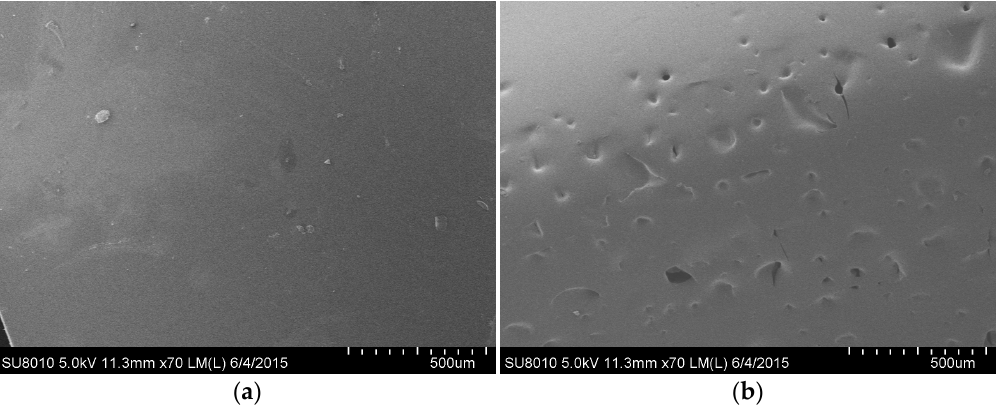
Figure 5. The scanning electron microscope (SEM) photograph of the ( a ) RF and ( b ) 20%-BRF resins.